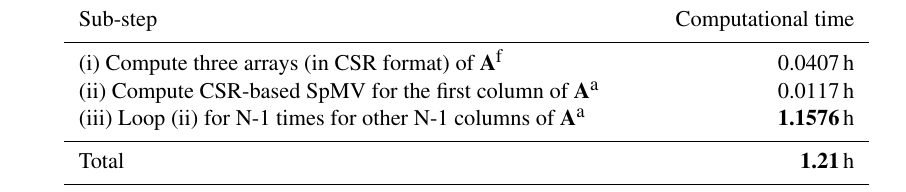
Table 4. Computational evaluation of the sub-steps of the sparse–dense matrix multiplication with compressed sparse row storage (CSR- based SDMM) for A a = A f X